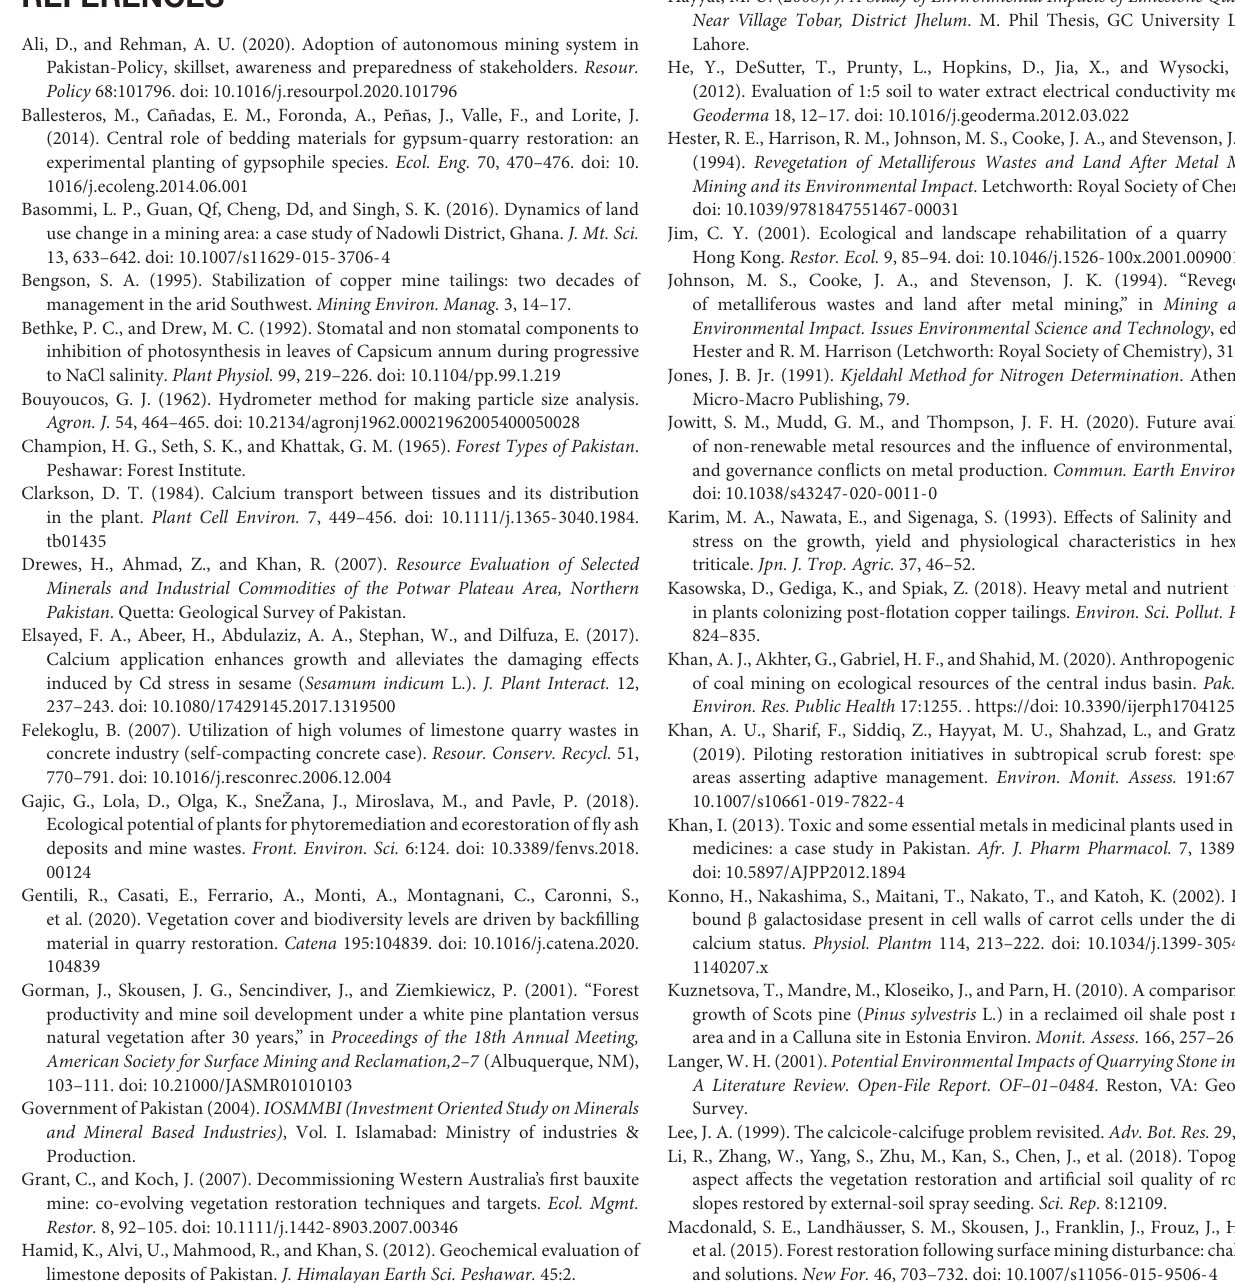
Supplementary Figure 2 | Effect of quarry waste on number of branches per plant in Acacia modesta over time. The asterisks indicate the significant difference of treatments means with the control ( T 0 ): ∗ P < 0.05, ∗∗ P < 0.01, and ∗∗∗ P < 0.0001. Supplementary Figure 3 | Effect of quarry waste on plant height of Adhatoda vasica over time. The asterisks indicate the significant difference of treatments means with the control ( T 0 ): ∗ P < 0.05, ∗∗ P < 0.01, and ∗∗∗ P < 0.0001. Supplementary Figure 4 | Effect of quarry waste on the number of branches per plant in Adhatoda vasica over